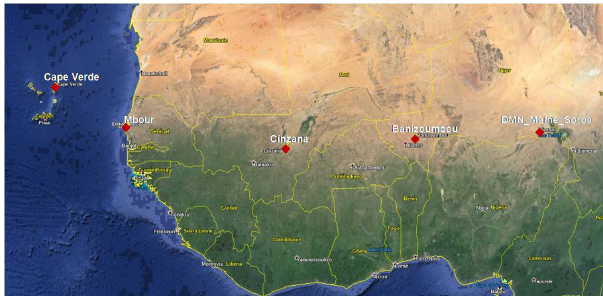
Figure 1. Location of the five AERONET sites used in this study to evaluate the ALADIN-simulated AOT over western Africa: Ban- izoumbou (Niger), Cinzana (Mali), Soroa (Niger), Mbour (Senegal) and Cape